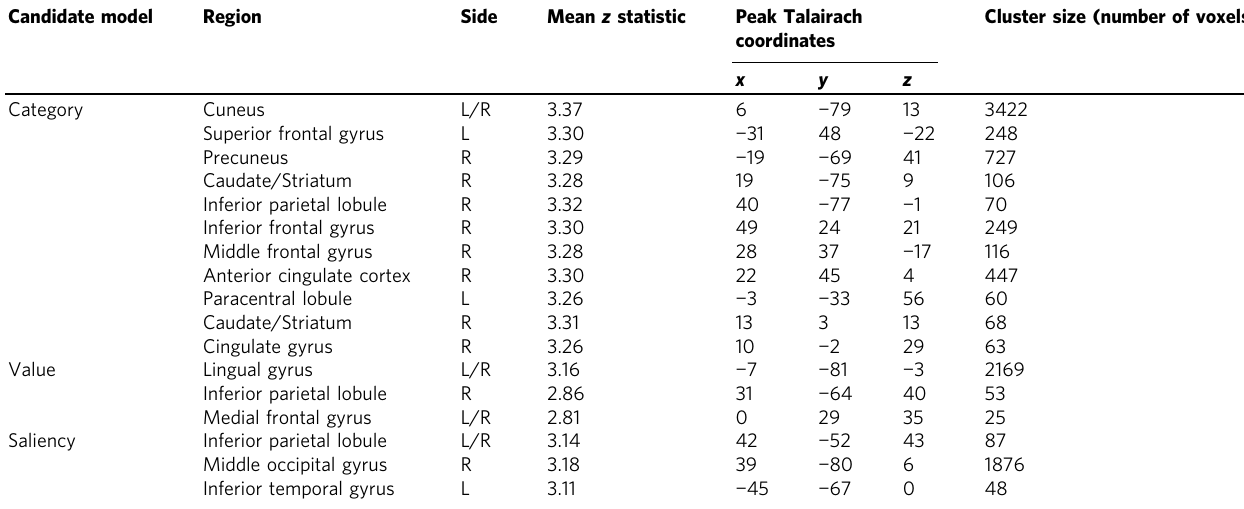
Table 2 Brain regions with statistically signi fi cant multivariate encoding of category, value, or saliency as identi fi ed by representational similarity analysis Candidate